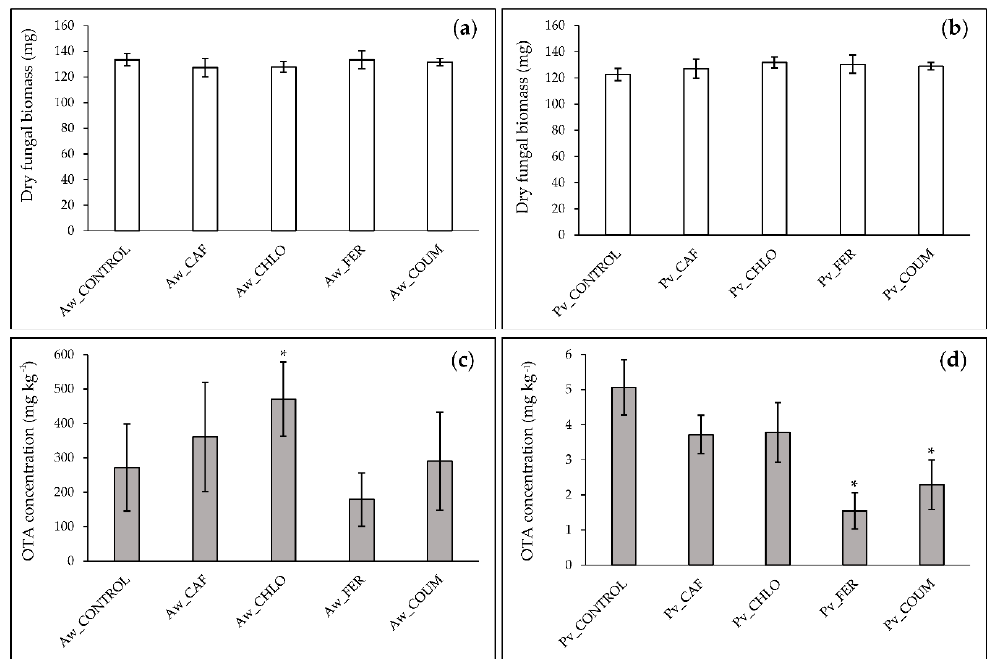
Figure 2. Effect of 0.5 mM caffeic (CAF), chlorogenic (CHLO), ferulic (FER), and p -coumaric (COUM) acids on fungal growth of ( a ) Aspergillus westerdijkiae (Aw) and ( b ) Penicillium verrucosum (Pv) and on ochratoxin A (OTA) production by ( c ) A. westerdijkiae and ( d ) P. verrucosum . Values are expressed as means ± standard deviation using four biological replicates. Asterix (*) indicates significant differences when compared with control (Student’s t test, control versus treated, p < 0.05).